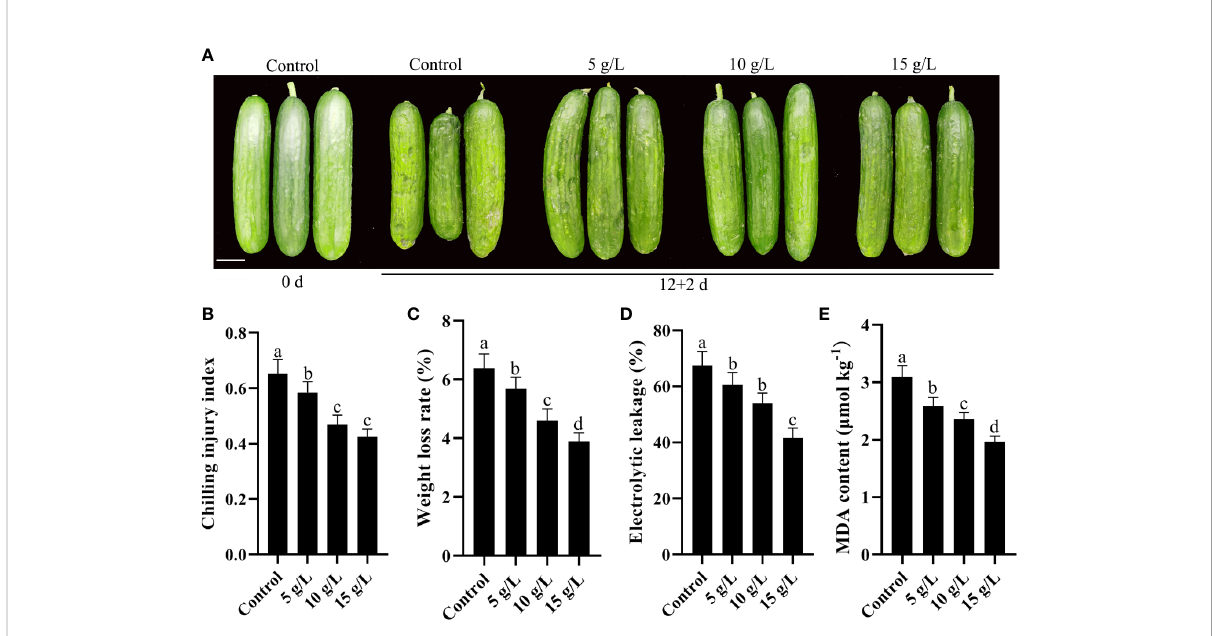
FIGURE 1 (A) Photograph comparing cucumbers treated with 0 (control), 5, 10, or 15 g L -1 fucoidan after 12 d of storage at 4°C. (B-E) Chilling injury index (B) , weight loss rate (C) , electrolytic leakage (D) , and MDA content (E) in cucumber fruit treated with 0, 5, 10, and 15 g L -1 fucoidan after 12 d of storage at 4°C. Values are presented as means ± SD of at least three replicates. Bars with different letters are signi fi cantly different at P< 0.05, as determined using Duncan ’ s multiple range tests.